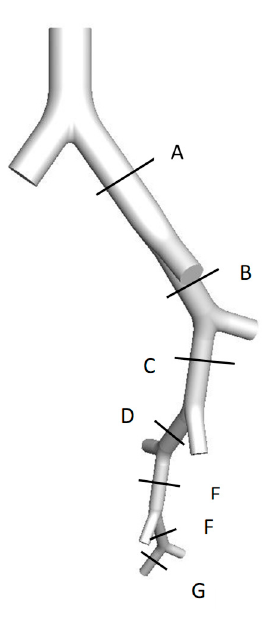
Figure 2. Axial air velocity and secondary airflow vector at various sections ( Re = 1000).